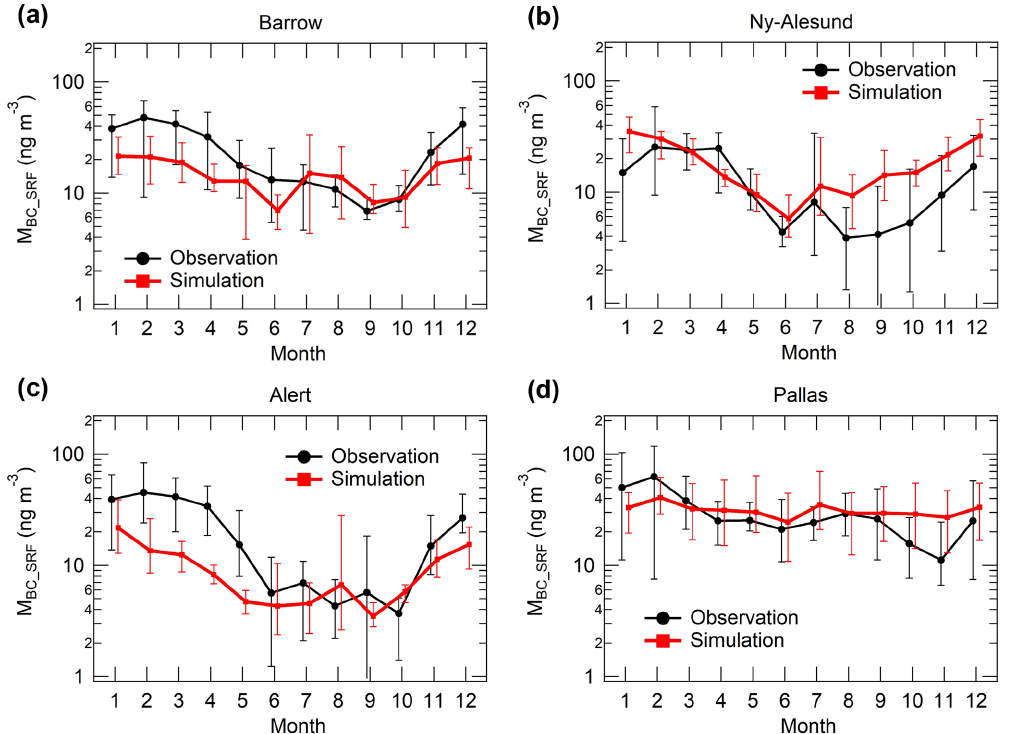
Figure 2. Comparisons between observations (black) and model simulations (red) for surface BC mass concentrations ( M BC_SRF ) at (a) Utqia˙gvik (formerly Barrow), (b) Ny-Ålesund, (c) Alert, and (d) Pallas. Model simulations in 2009–2015 were compared with ob- servations in 2009–2015. The error bars show the interannual variability (maximum–minimum ranges) of M BC_SRF . M BC_SRF is shown at standard temperature and pressure in both observations and model simulations.